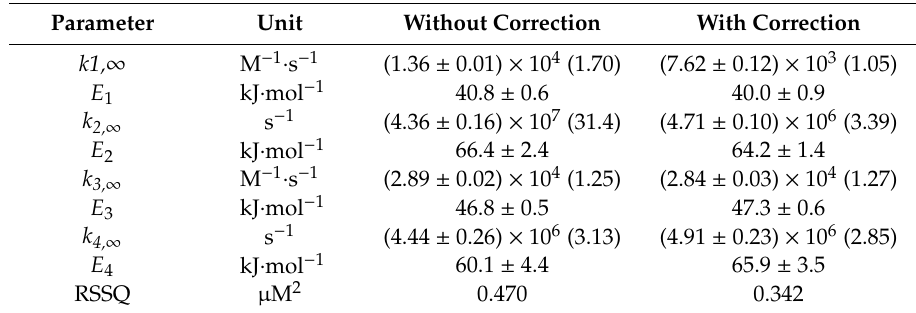
Table 2. Parameter estimates for set 1 (methanol as solvent). For the pre-exponential factors, the deviation is indicated between brackets.